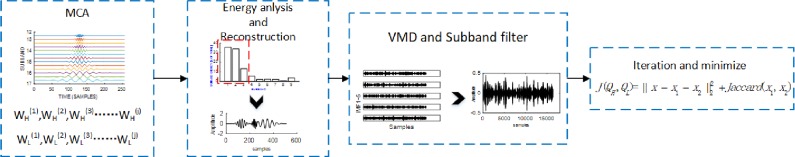
Main idea of the proposed method RSAVMD.In order to select the appropriate QH and QL, the signal (after TQWT)was processed by MCA firstly, energy analysis was conducted for each component, the component with more energy was reconstructed, AVMD analysis was conducted for the reconstructed component, and the above process was iterated until minimizing the objective function. At this point, envelope spectrum analysis was performed for AVMD results with high resonance components.